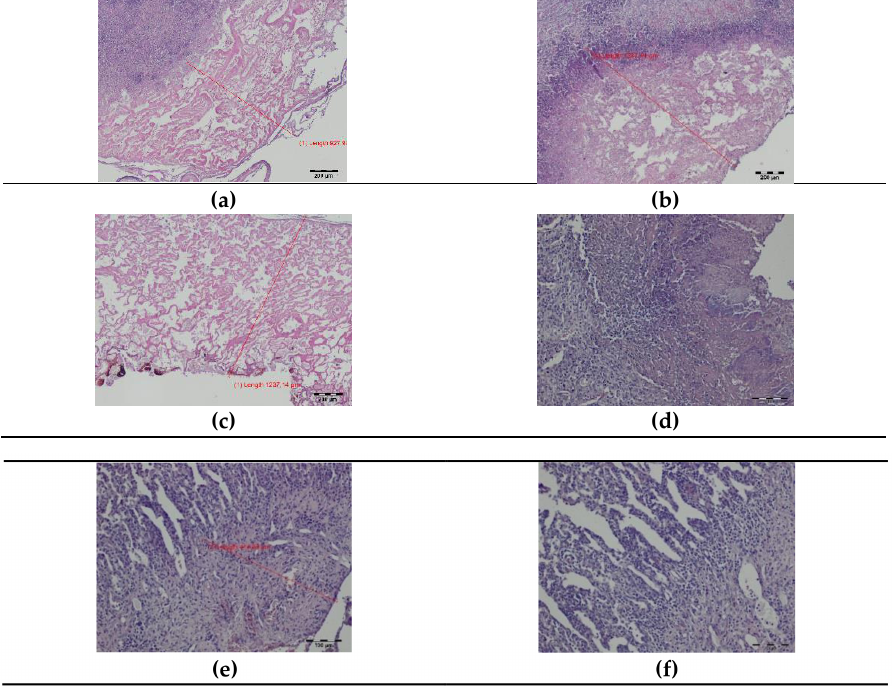
Figure 6. Histopathology of the lungs seven days after cutting with a thulium-doped fiber laser (TDFL): ( a – c ) superficial zone of thermal damage, magnification 40 × ; ( d , e ) deeper zone of granulation and connective tissue, magnification 40 × ( d ); 100 × ( e ); ( f ) a border between laser thermal damage zone and a healthy lung tissue, magnification 100 × ; HE